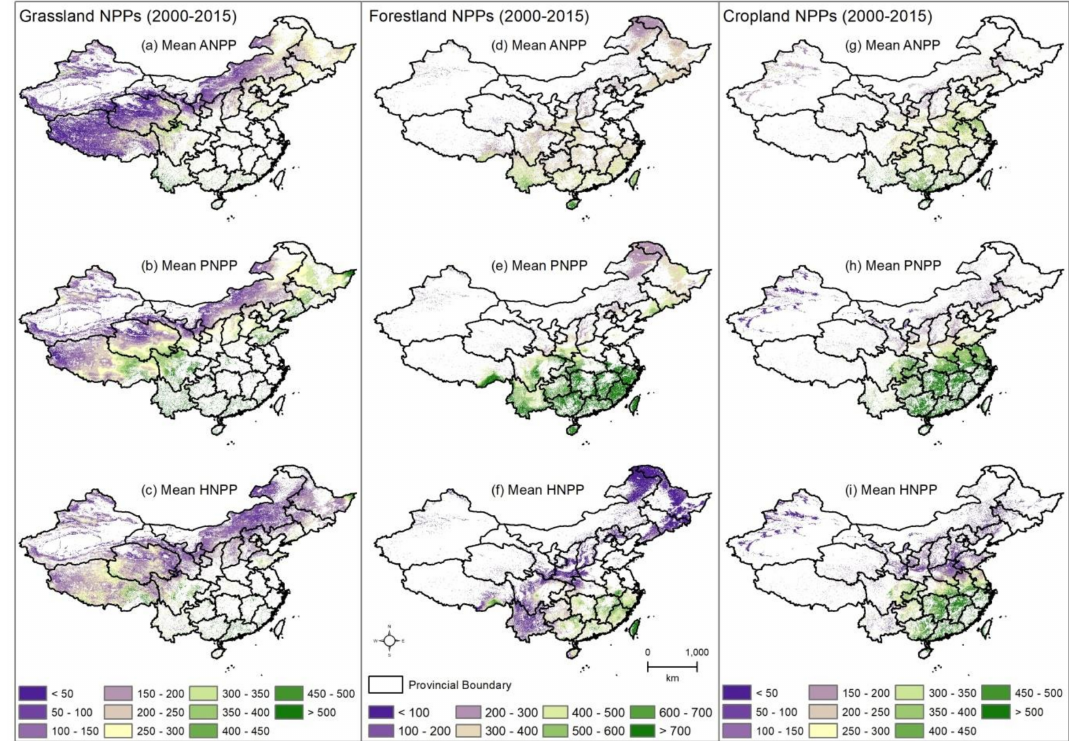
Figure 7. Mean actual NPP (ANPP), mean potential NPP (PNPP), and mean human-induced NPP (HNPP)fortherestorationperiod: ( a – c )arethemeanANPP,PNPP,andHNPPforgrassland, respectively; ( d – f ) are the mean ANPP, PNPP, and HNPP for forestland, respectively; ( g – i ) are the mean ANPP, PNPP, and HNPP for cropland,